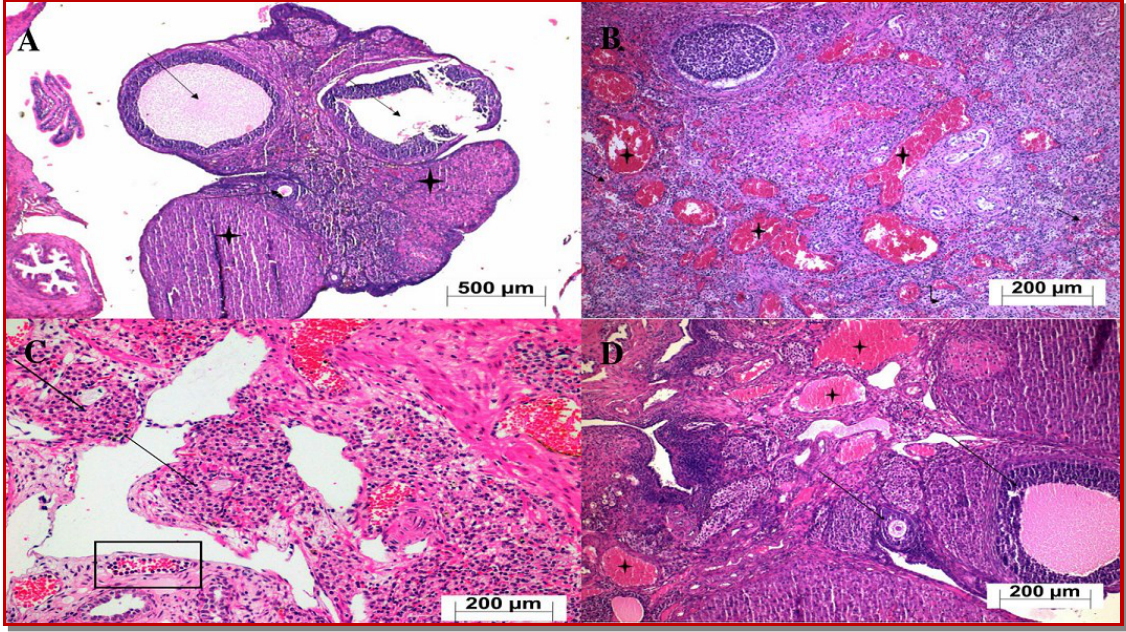
Figure 1: Histopathological evaluation of ovarian tissue in experimental groups Ovarian tissue of the normal follicle structures (arrow) and corpus luteum (asterisk), H&E x40 (A). Cyclophosphamide adminis- tered cyclophosphamide group ovarian tissue; diffuse congestion (asterisk), hemorrhage (arrow) and edema (zigzag arrow), H&E x100 (B). Cyclophosphamide administered cyclophosphamide group ovarian tissue; degenerate follicle structures (arrow), poly- morphonuclear leukocyte infiltration (square), H&E x100 (C). Ovarian tissue of cyclophosphamide plus thymoquinone group; vascular structures with congestion (asterisk), follicle degeneration (arrows), H&E x100